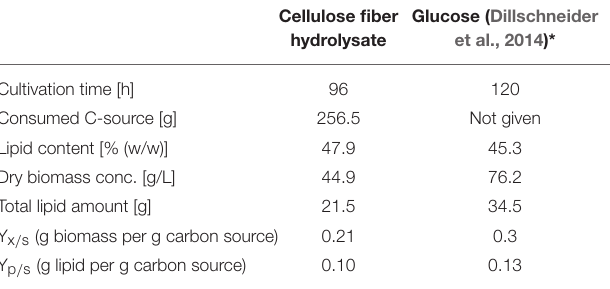
TABLE 1 | Summary of measured and calculated process parameters of SCO production with C. curvatus ATCC 20509 using cellulose fiber hydrolysate from beech wood in comparison to batch cultivations with pure